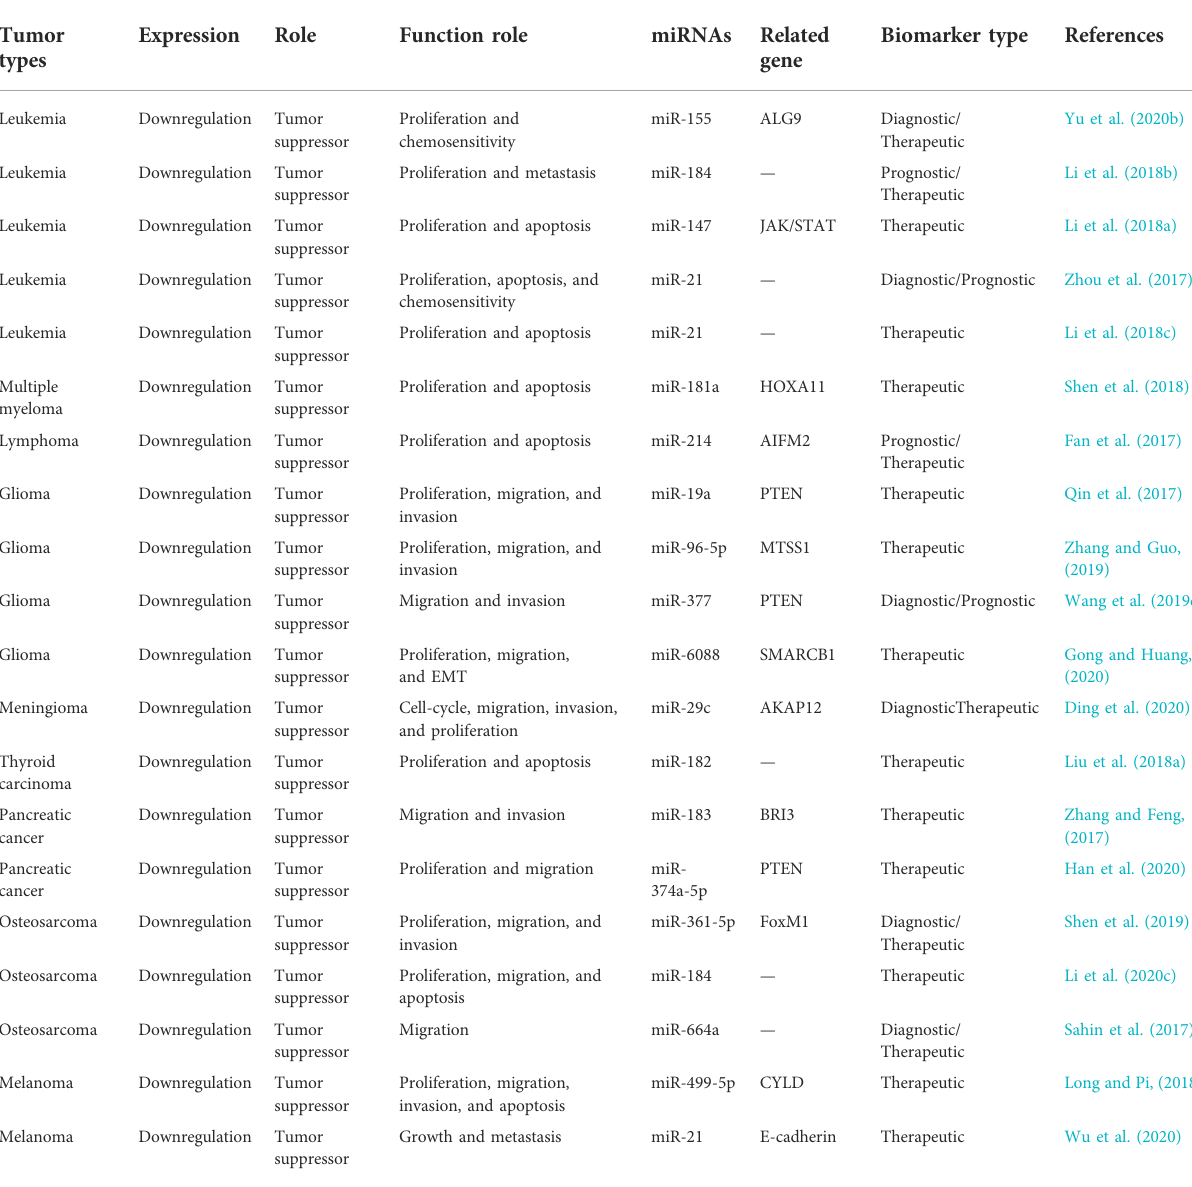
TABLE 5 Characterization of MEG3 function in hematological, neuroendocrine, and other system